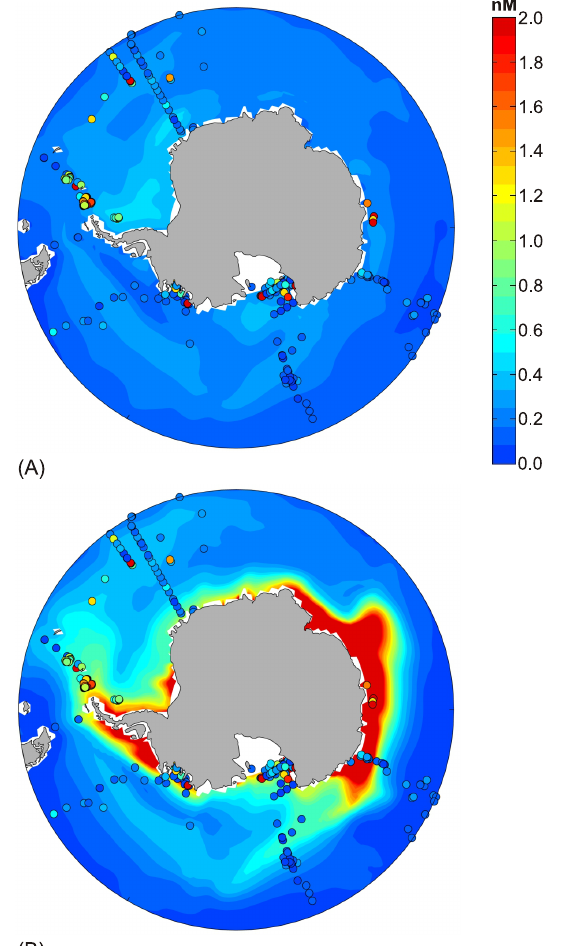
Figure 2. The geographical distribution of the impact of iron in- puts upon modelled surface (0–100m) ocean iron concentrations is shown for (A) Scenario A (dust only) and (B) Scenario E (dust, subglacial meltwater (where [Fe] = 3µM) and icebergs). Observed surface ocean iron concentrations are shown as coloured circles, and are derived from (Tagliabue et al., 2012) with data from the Amund- sen Sea from (Gerringa et al., 2012).